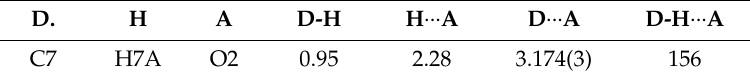
Table 3. The list of selected hydrogen bond Å in compound 2 .